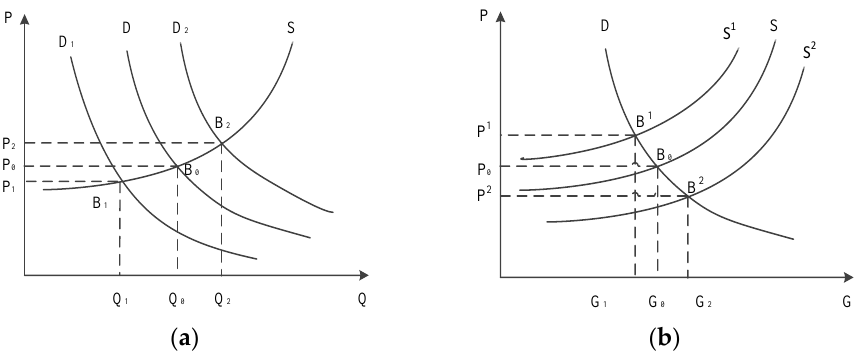
Figure 1. The impact of supply and demand on ticket price. ( a ) The demand curve; ( b ) The supply curve.